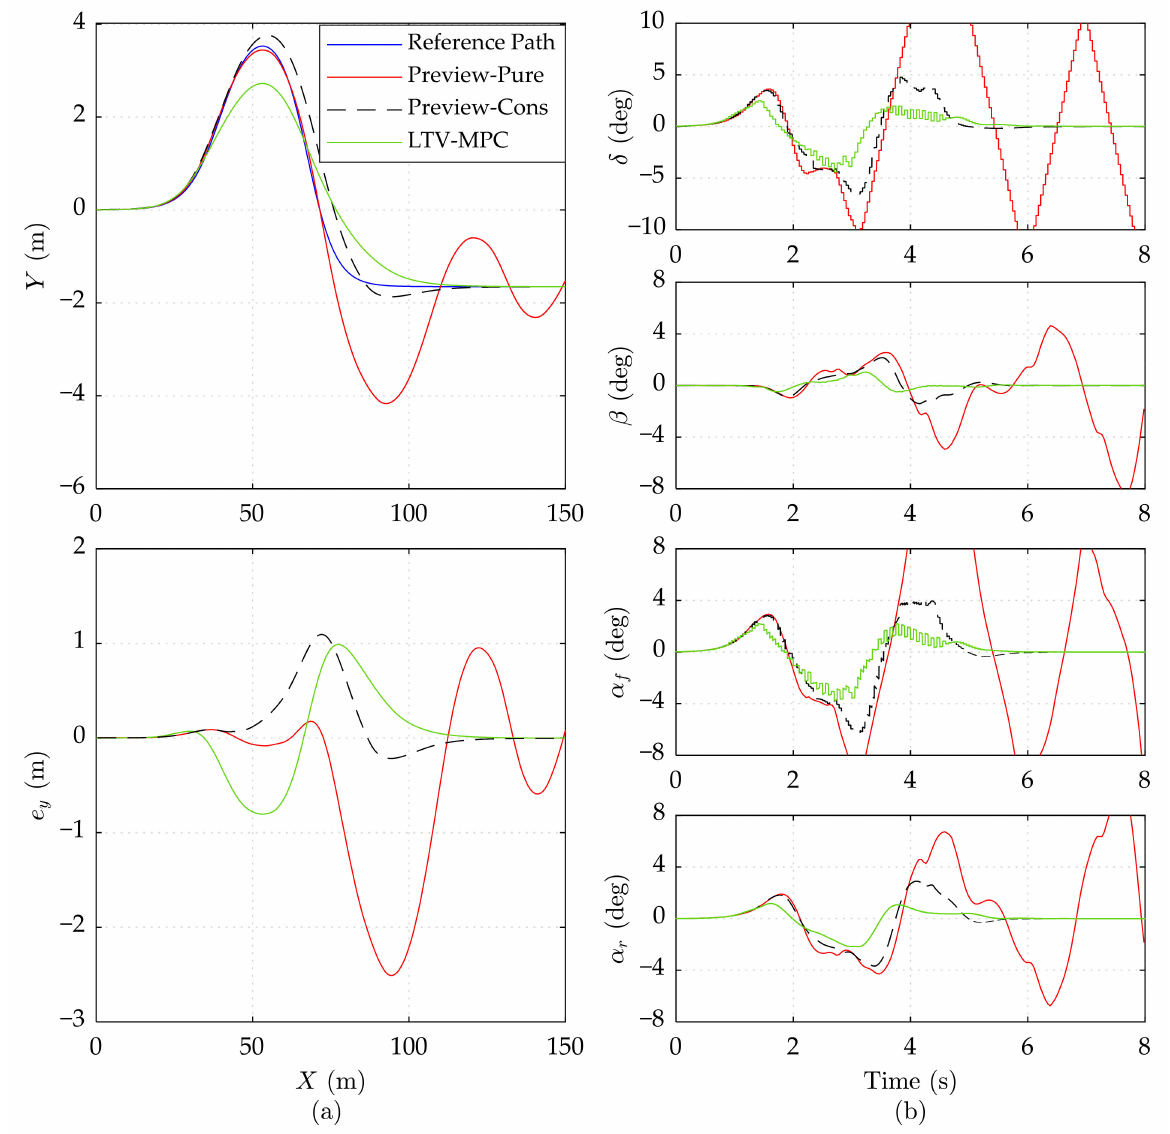
Figure 5. Simulation results of three controllers on the high adhesion road at 20 m/s speed. ( a ) Vehicle driving trajectory, lateral error e y . ( b ) Front wheel steering angle δ , mass center slip angle β , front wheel slip angle α f , and rear wheel slip angle α r . The results of Preview-Pure beyond range are cut